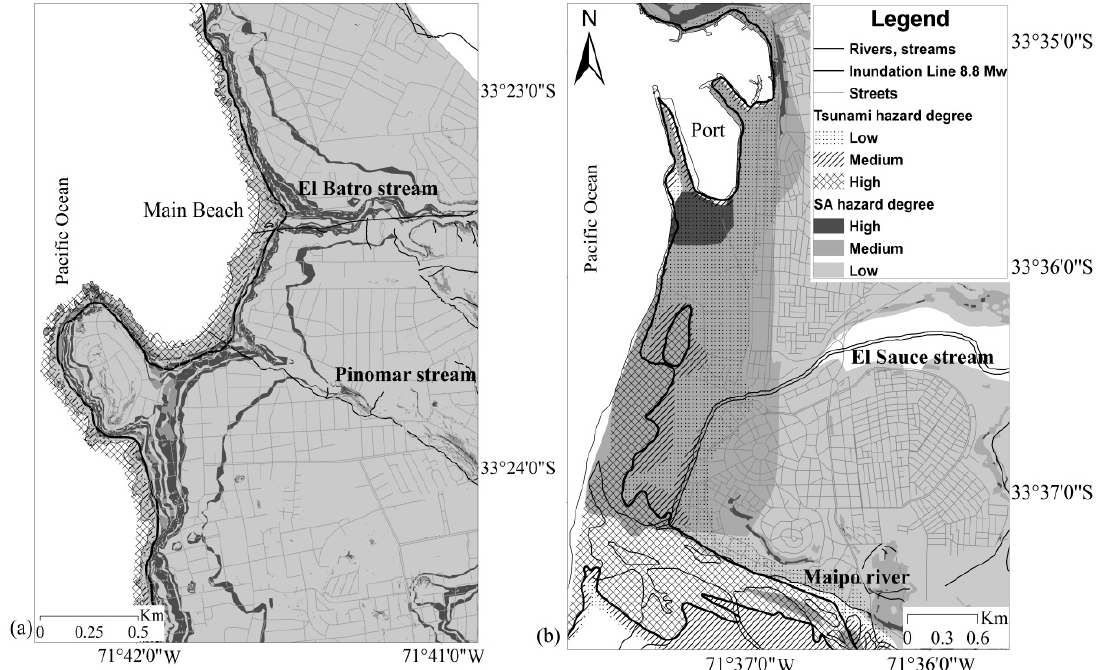
Figure 5. Integrated degree of hazard due to seismic wave amplification (SA) and tsunami inundation at ( a ) El Quisco and ( b ) San Antonio.